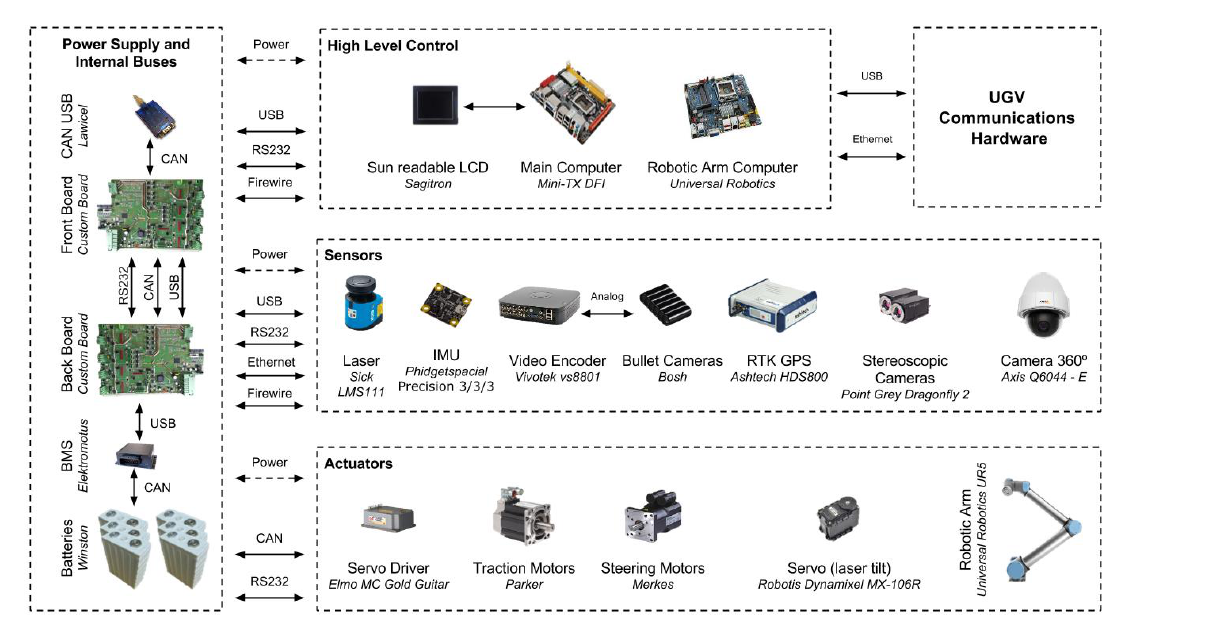
Figure 6. UGV’s modular hardware architecture. Dashed arrows represent power supply connections. Solid arrows represent device-device intra-robot wired communication links (e.g., RS232,